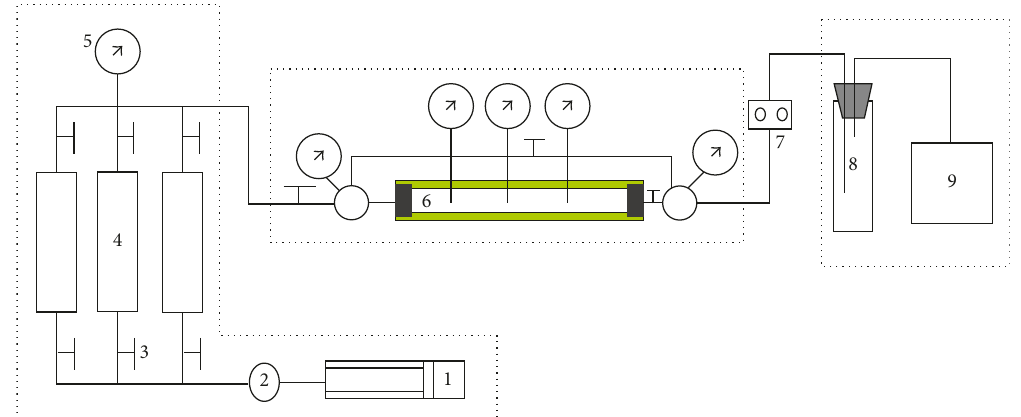
Figure 3: Experiment apparatus of CO 2 injection. 1: Liquid pump; 2: six-way valve; 3: valve; 4: gas and liquid container; 5: